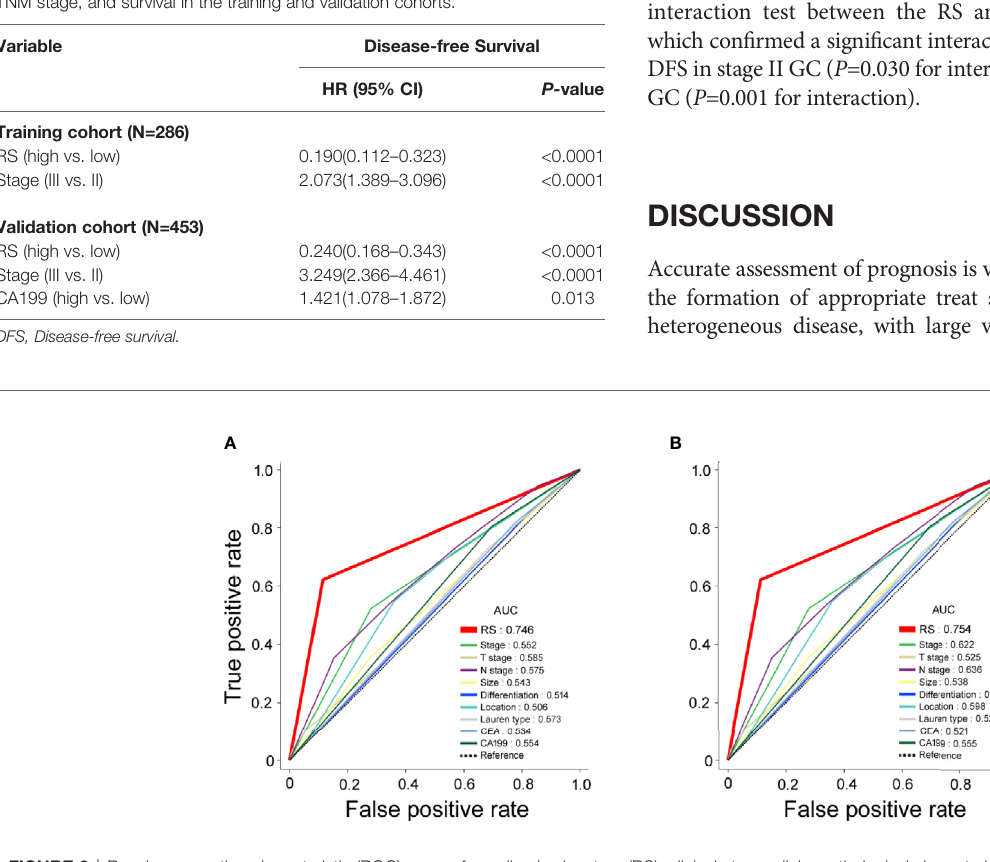
FIGURE 2 | Receiver operating characteristic (ROC) curves for radiomic signature (RS), clinical stage, clinicopathological characteristics as predictors of 5-year disease-free survival (DFS) in the training and validation cohorts. (A) Training cohort; (B) validation cohort.